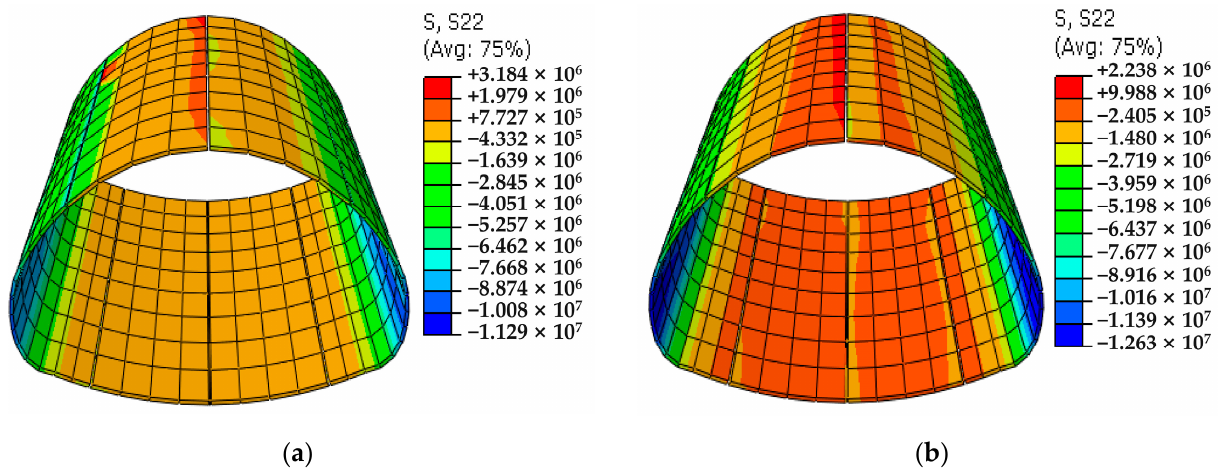
Figure 17. The vertical stress of the second primary lining in different conditions (unit: Pa): ( a ) Con- dition 1 and ( b ) Condition 2.